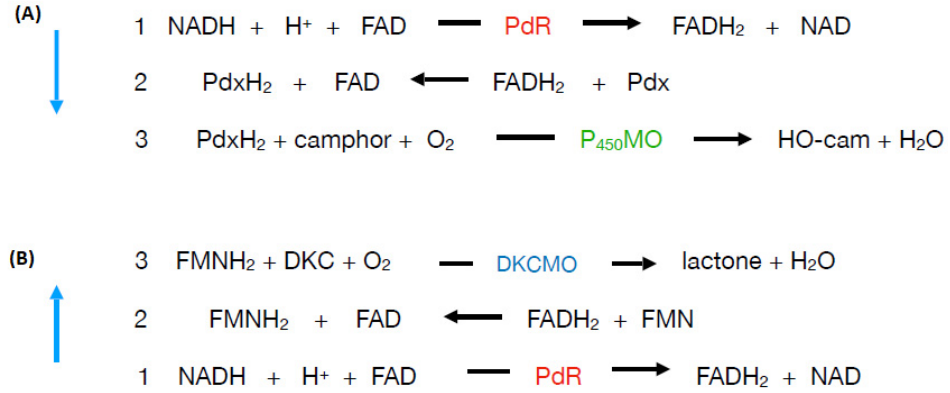
Figure 17. Schematic of the two contrasting roles of putidaredoxin reductase (PdR) in camphor-grown P. putida ATCC 17453. ( A ). cytP450MO (camphor 5-monooxygenase): Pdx (putidaredoxin) ( B ). 2,5-DKCMO (2,5-diketocamphane 1,2-monooxygenase): DKC (2,5-diketocamphane).